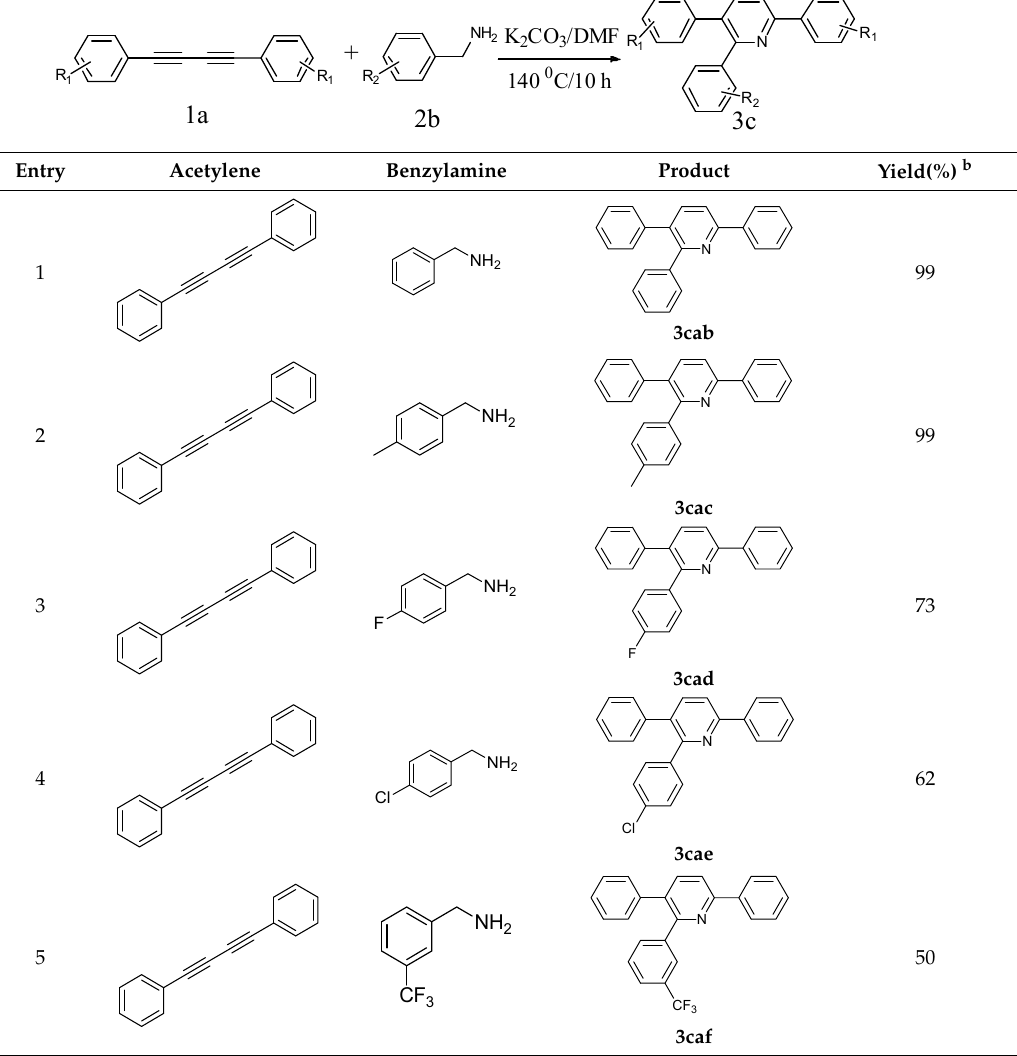
Table 2. Synthesis of arylated pyridines from conjugated acetylenes and substituted benzylamines under optimized conditions. a